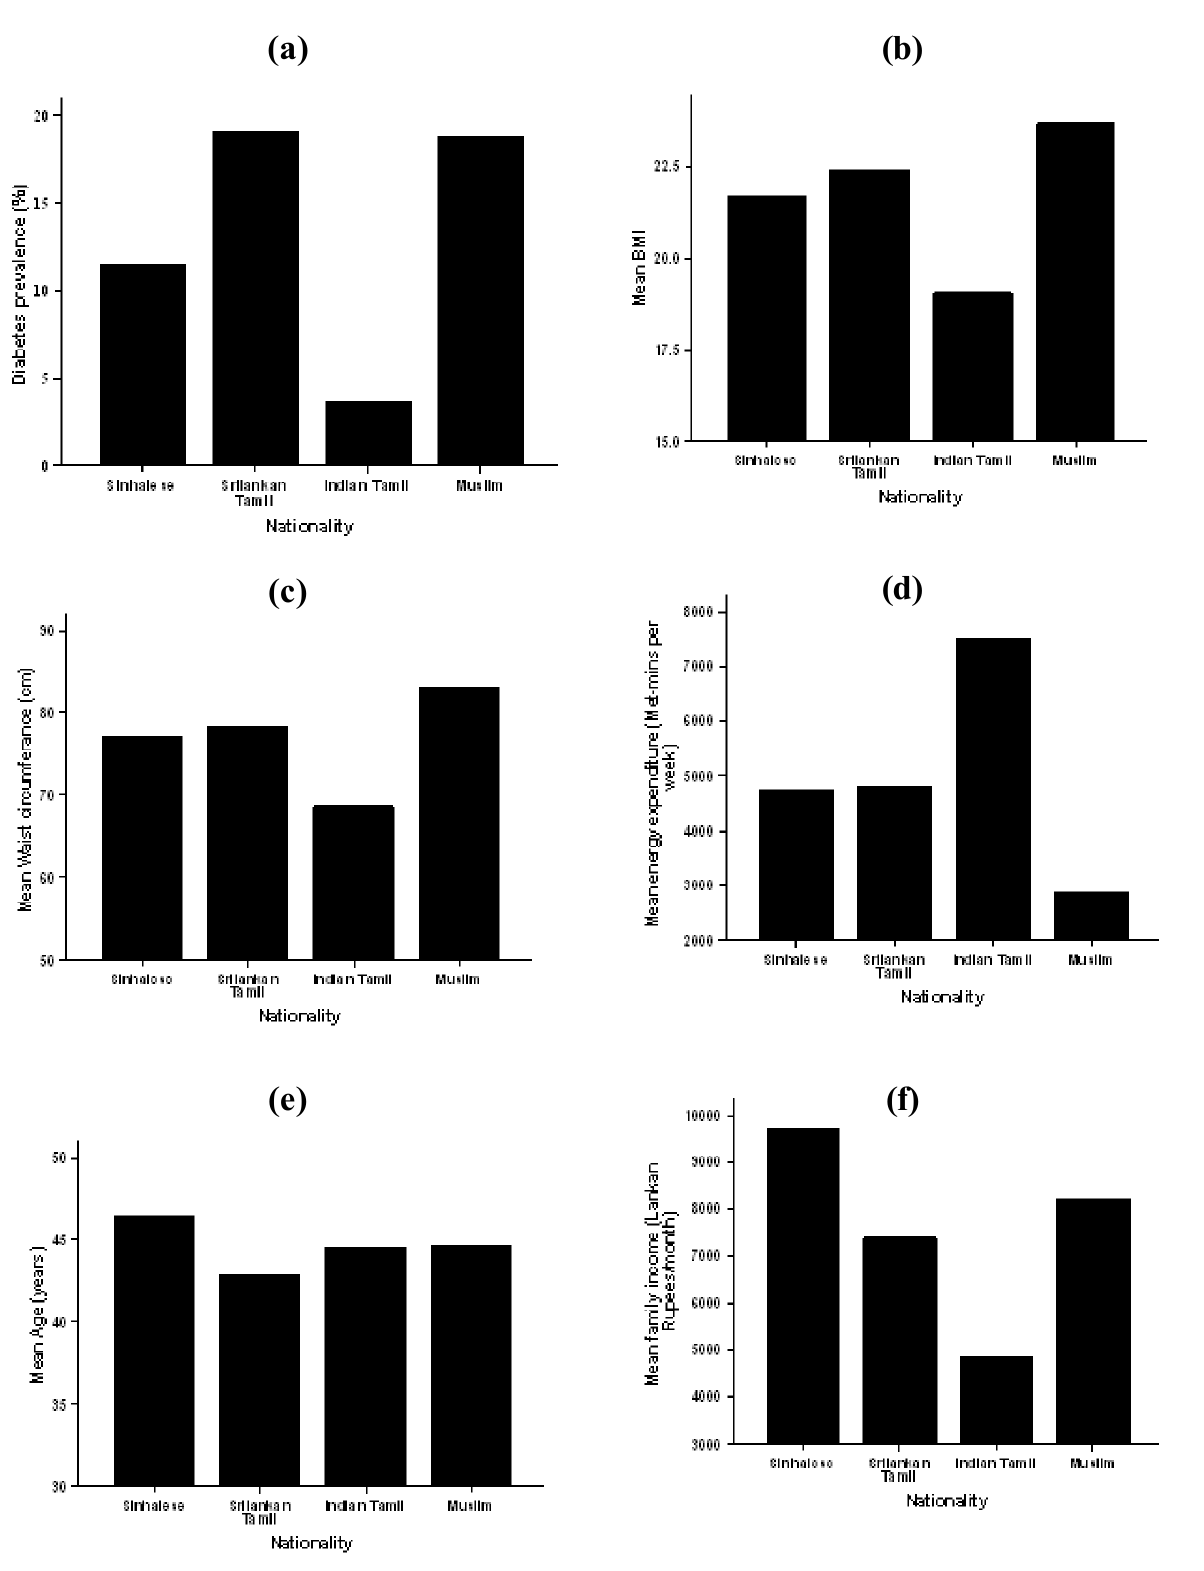
Figure 2. Prevalence of diabetes and the distribution of risk factors and socio-demographic correlates among different ethnic groups in Sri